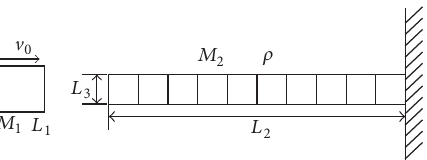
Figure 7: DDA model of impact of a block on the